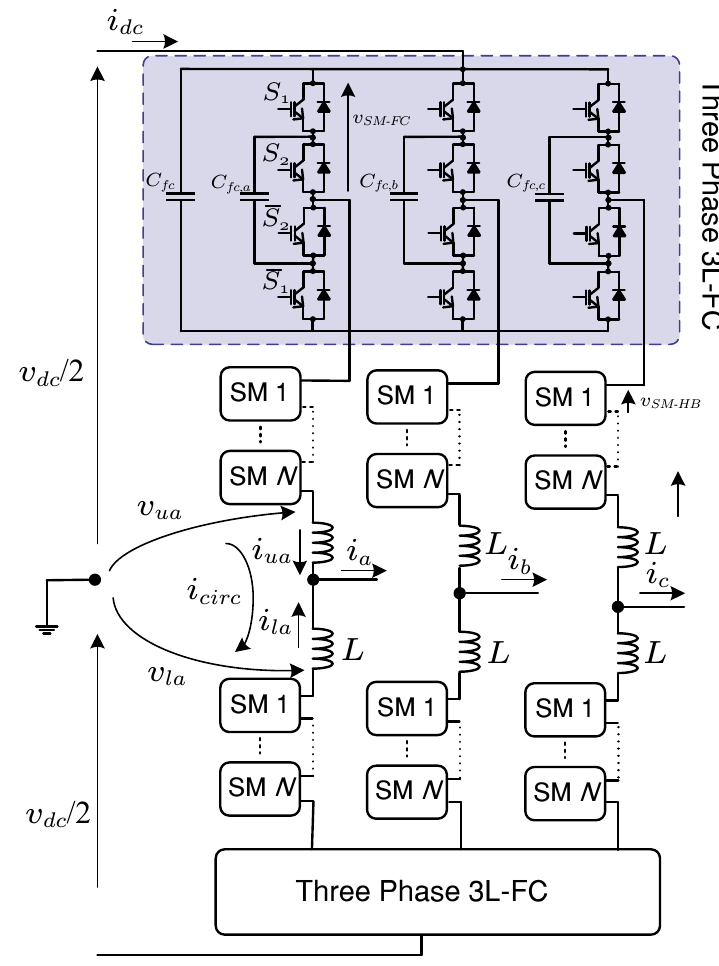
Figure 2. Proposed three-phase hybrid modular multilevel converter (MMC).